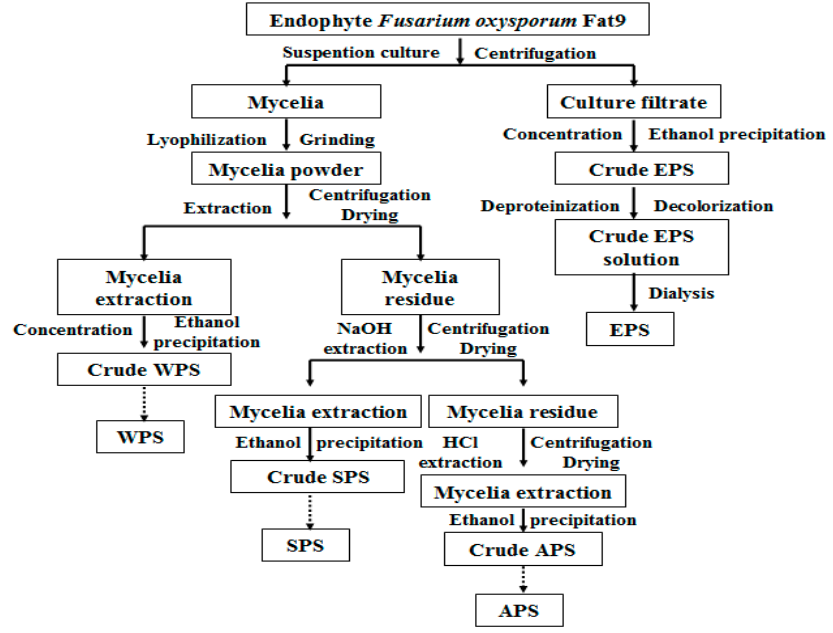
Figure 7. The preparation scheme of EPS, WPS, SPS, and APS of endophyte F. oxysporum Fat9.